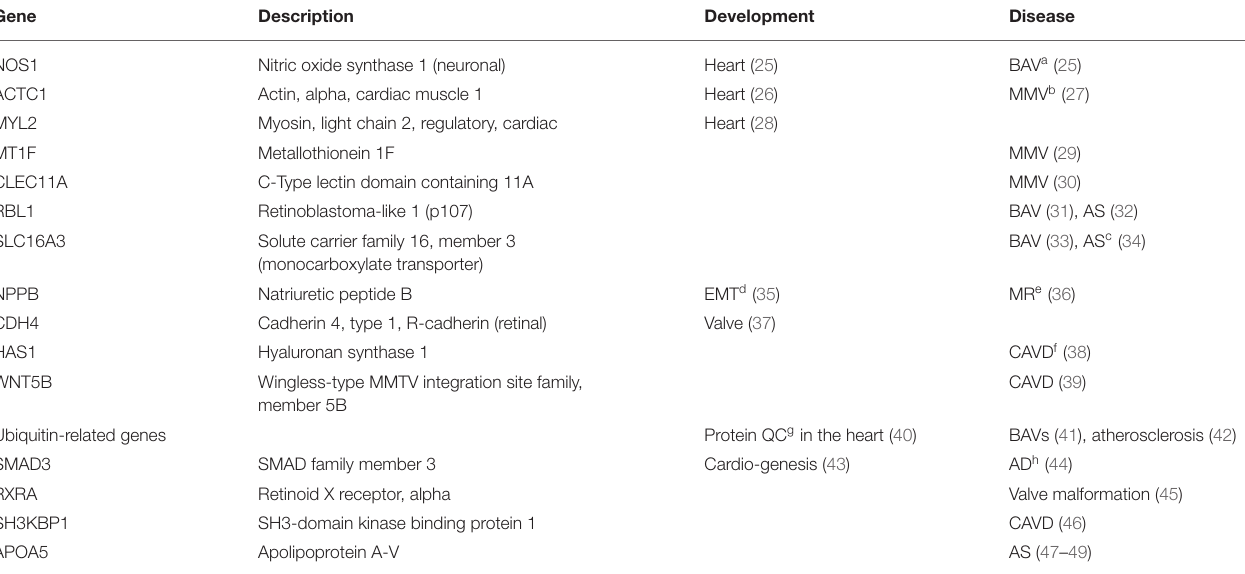
TABLE 3 | Genes associated with differentially methylated promoters between aortic and mitral valve tissue and their involvement in valve development and disease.